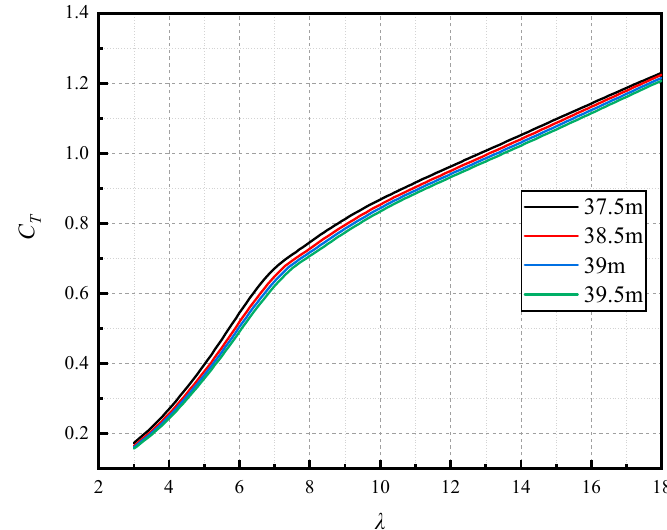
Figure 5. C T - λ curve of turbines with different blade lengths.